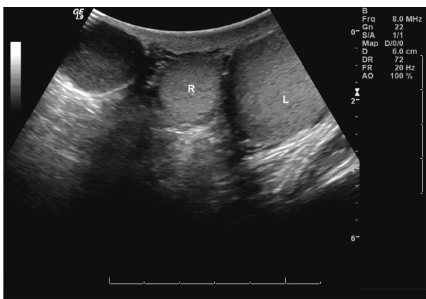
Figure 2: Coronal oblique sonogram shows an oval solid hypoe- choic mass (arrow) separate from the right and left testes (T).